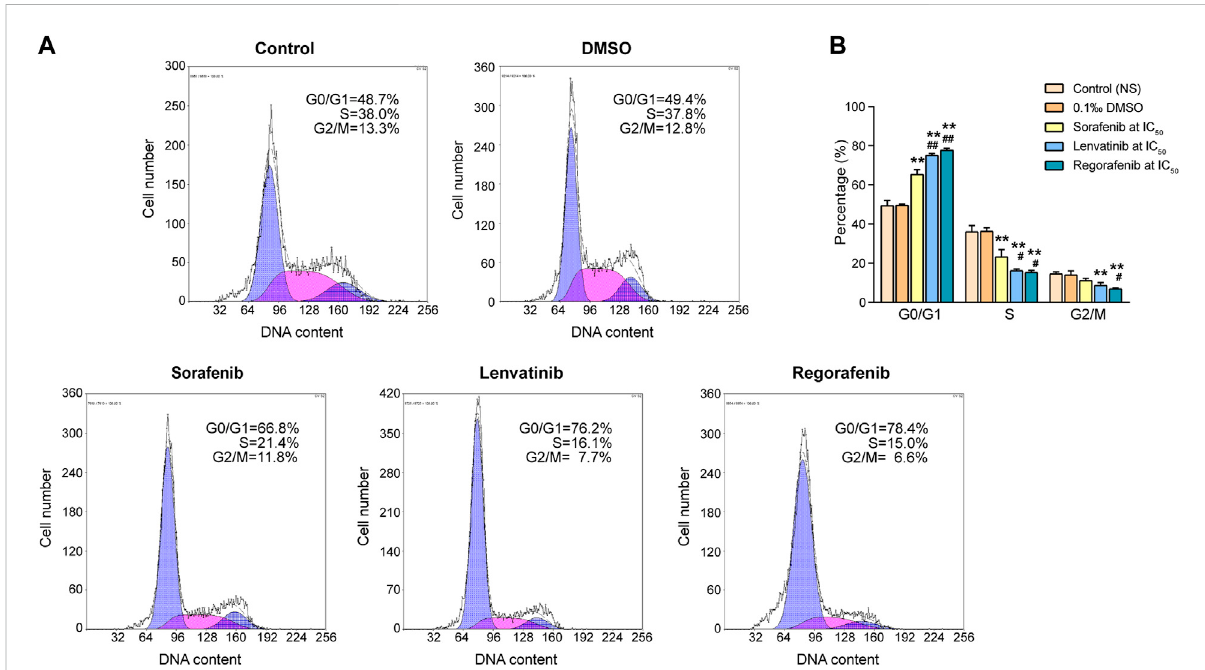
FIGURE 2 Effects of 72 h incubation with respective sorafenib, lenvatinib and regorafenib at their IC 50 on cell cycle progression in Huh-7 cells (A) Representative histograms fromsortingofpropidiumiodide-stained cells by fl owcytometry (B) Bargraphshowingthepercentage ofcellsinvarious phases of cell cycle distribution. Each bar presents mean ± SD ( n = 3). The ** p < 0.01 versus DMSO; # p < 0.05 and ## p < 0.01 versus sorafenib. NS, normal